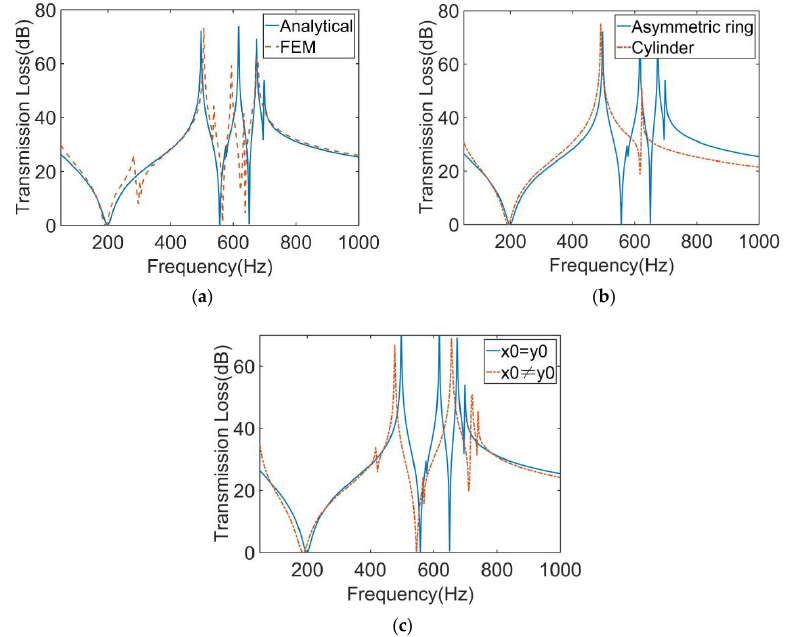
Figure 9. ( a ) Comparison of the analytical and numerical results for the STL curve of the MAM with four asymmetric rings. ( b ) Comparison of the MAMs with four asymmetric rings and four cylinders for the STL curve. ( c ) Comparison of the MAMs with mass positions x 0 = y 0 and x 0 ≠ y 0 for the STL curve.